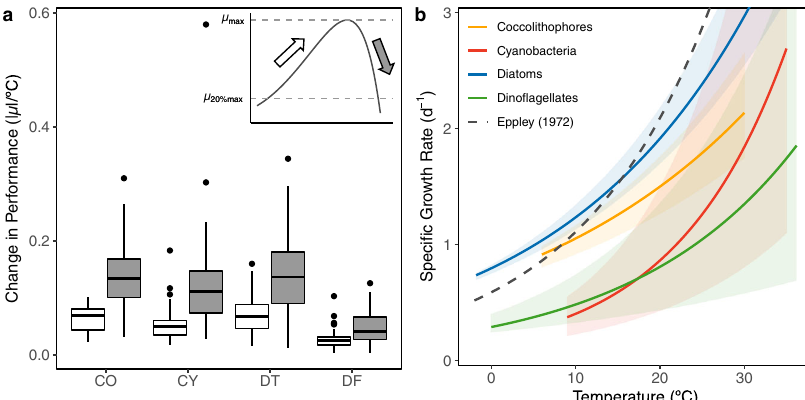
Fig. 2 Comparison of thermal dependencies among phytoplankton functional types. a Absolute change in performance for each PFT (Coccolithophores = CO, cyanobacteria = CY, diatoms = DT, dino fl agellates = DF), determined by analyzing the rate of change from 20% of the maximum growth rate ( µ 20%max ) to the µ max . Colors correspond to the rates approaching (white) or descending (gray) from the µ max . Box plots extend from the fi rst to the third quartile, with a line denoting the median, whiskers extending to the greatest value within 1.5× interquartile range, and points displaying data outliers. Only strains for which reaction norms could be fi t were used in calculations (CO = 30, CY = 32, DT = 135, DF = 46). All groups were negatively skewed resulting in greater rates of growth descent from the µ max . b Functional group maximum growth rates (modeled µ max ) as a function of temperature fi t using growth measurements according to Bissinger et al. 29 and compared with that from Eppley 28 . 95% con fi dence intervals (shading) were determined using Markov chain marginal bootstrapping 75 . Dino fl agellates were characterized by the smallest performance changes overall, as evidenced by their relatively fl atter reaction norms (Fig.